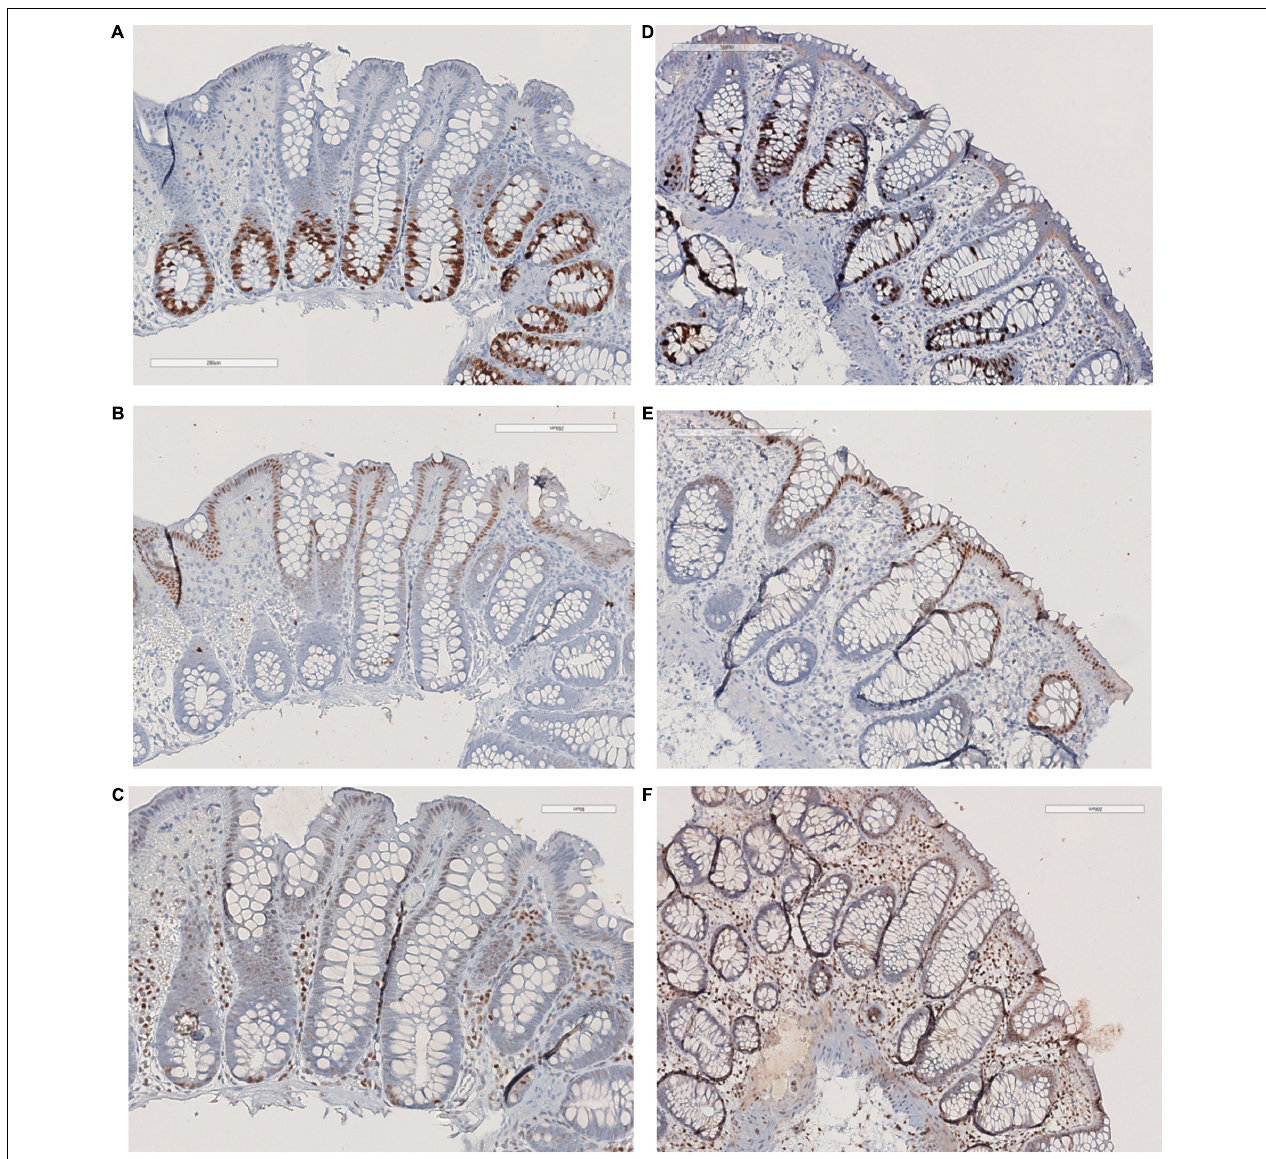
FIGURE 4 | Colonic mucosa: (A) KI67, (B) p21, (C) p27; Control case: (D) KI67, (E) p21, (F)